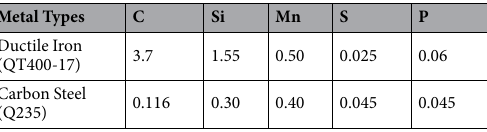
Table 1. Each coupon was polished (using a series of waterproof abrasive papers of 500, 800, 1000, and 1200 grit), degreased in acetone, dehydrated in absolute ethanol, dried, weighed and stored in the desiccators. For the elec- trochemical study, the same types of metals were further fabricated to the working electrodes with a working area of 1 cm 2 . The area experienced the similar treatments to the coupons except for being weighed. The soil samples were extracted from 1 m depth underground (where pipes are usually buried) in a field in Tianjin (China). The soil samples were characterized as received according to the National Standards 24 , and the average values were summarized in Table 2. After natural drying and sieving (10 meshes), the soils were stored